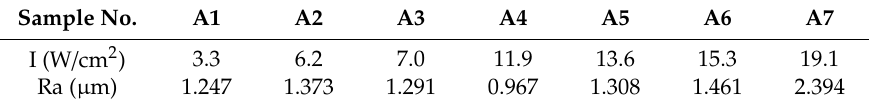
Table 3. The relationship between laser intensity and roughness on the cleaned surface. Sample No.